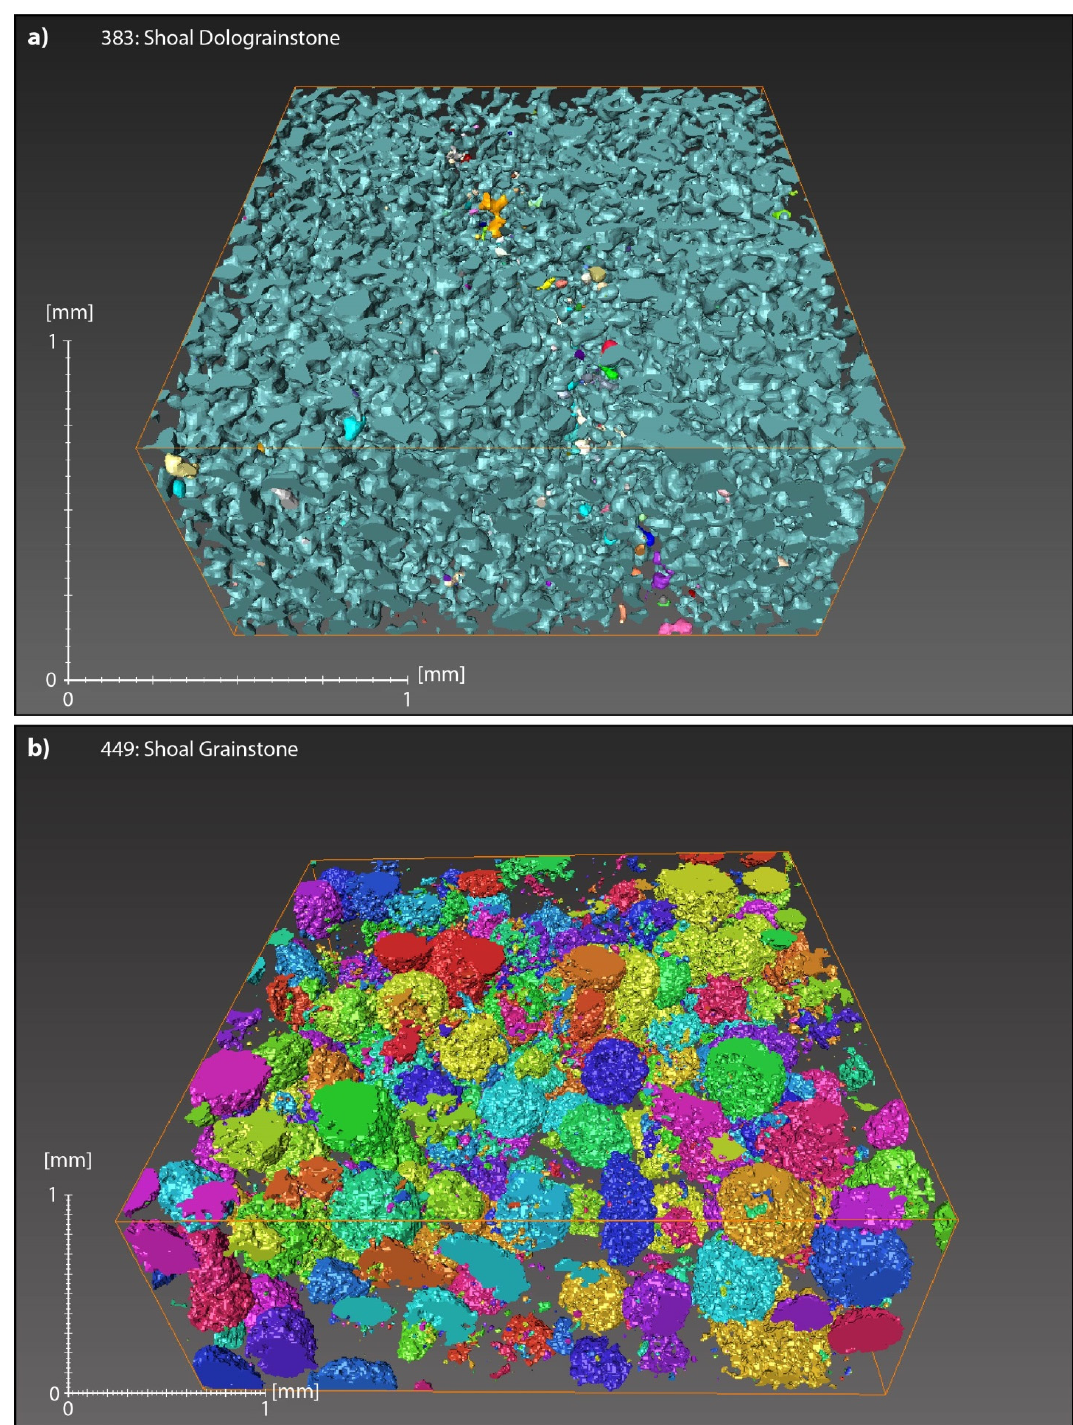
Figure 12. Volume reconstruction of moldic and intercrystalline pores in dolgrainstone shoal sample 383 and grainstone sample 449. The image is displayed using a cyclic colormap so that unconnected pores in close proximity are likely to be shown in a different color. This enables distinguishing between separated and connected pores. The displayed scale bars account for the bounding-box center. ( a ) The color distribution indicates that the moldic and intercrystalline pores of sample 383 are well connected (turquoise) with only minor isolated pores (all other colors). ( b ) Sample 449 showing poorly connected moldic pores. For details see